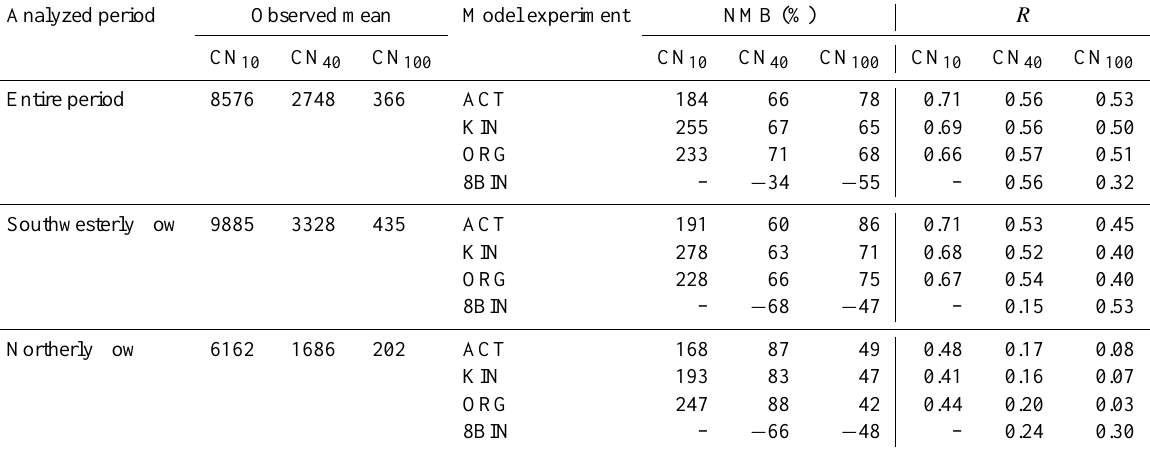
Table 1. Observed mean and simulation summary statistics for aerosol number concentrations for particle diameters ≥ 10nm (CN 10 ), ≥ 40nm (CN ≥ 100nm (CN 40 ), and 100 ). The normalized mean bias (NMB) and correlation coefficient ( R ) are calculated between simulated and observed number concentrations at the CARES T0 site during the 7–16 June 2010 period.